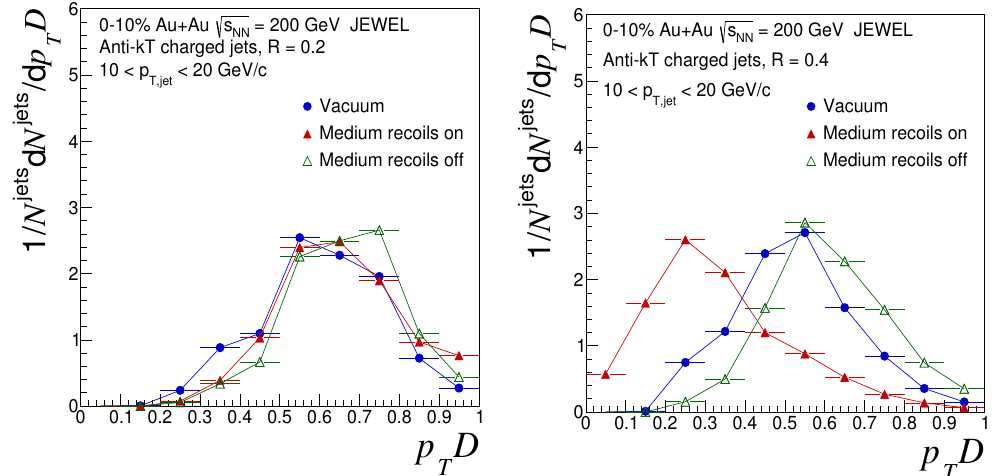
Figure 6. Momentum dispersion for jets with p T of 10–20 GeV/ c and R = 0.2 ( left ) and R = 0.4 ( right ) √ s NN = 200 GeV. in central Au+Au collisions at